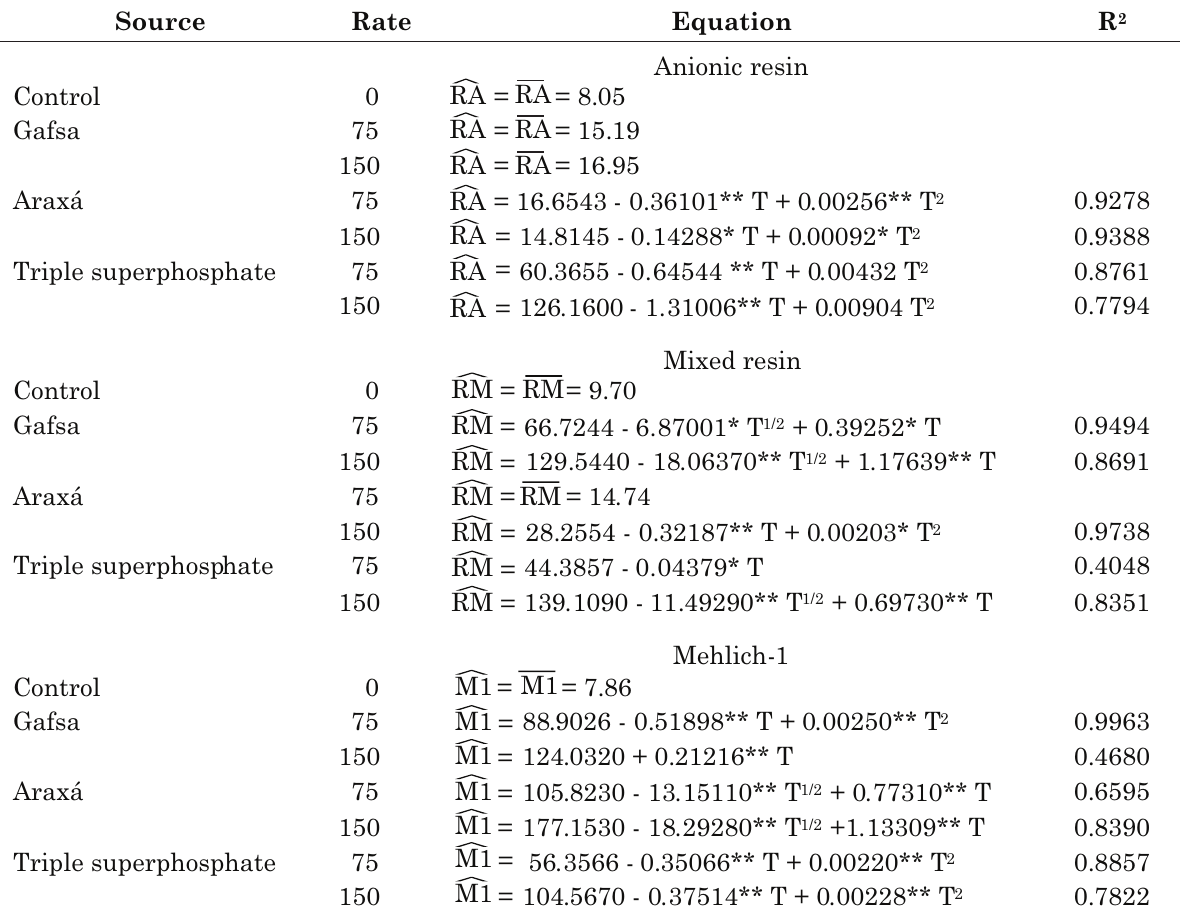
Table 6. Equations for P contents (mg dm -3 ) by the extractants: Anionic resin (AR), Mixed resin (MR) and Mehlich-1 (M1), in function of the contact time (T, in days) with a sandy loam Yellow Latosol (LA), after application of P sources at different